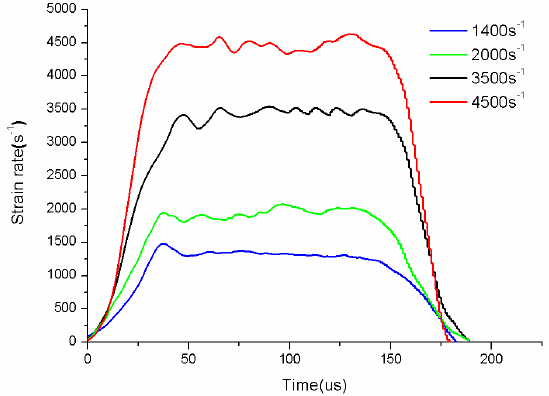
Figure 6. The fixture device connecting the specimen in quasi-static tension tests.